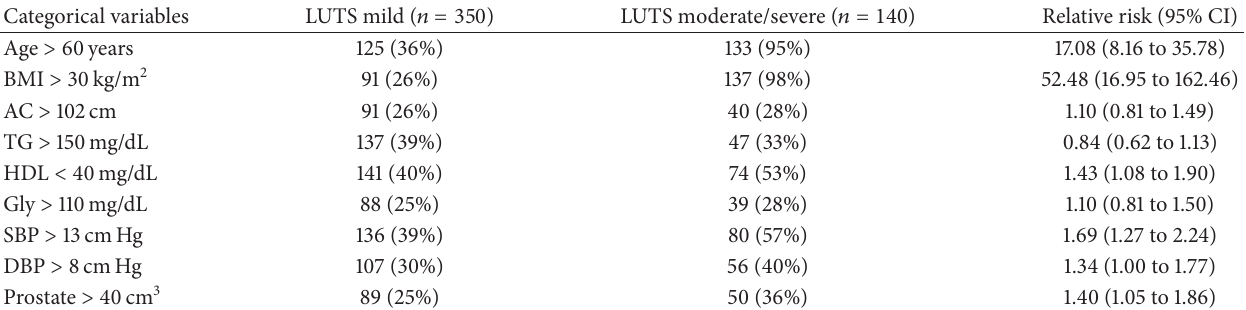
Table 3: Relative risk for lower urinary tract symptoms based on demographic and metabolic